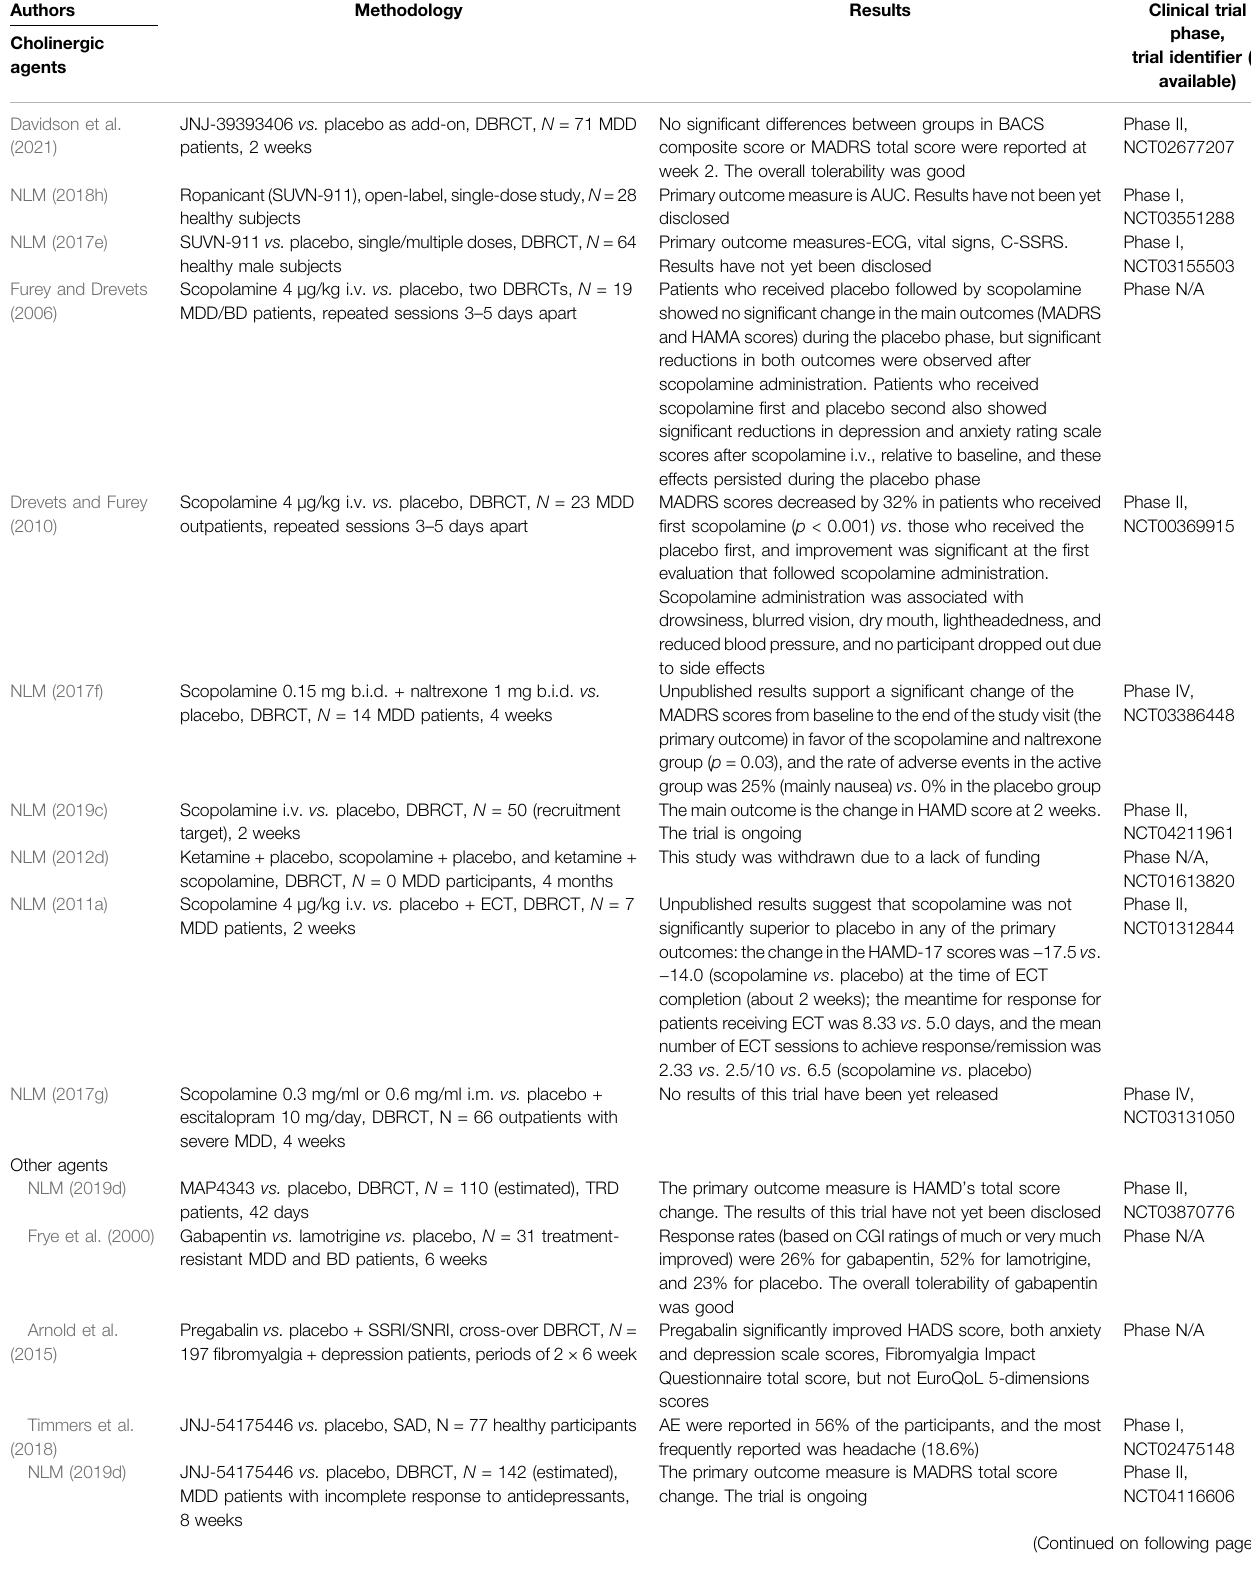
TABLE 4 | Cholinergic receptor modulators and other agents with antidepressant properties in the